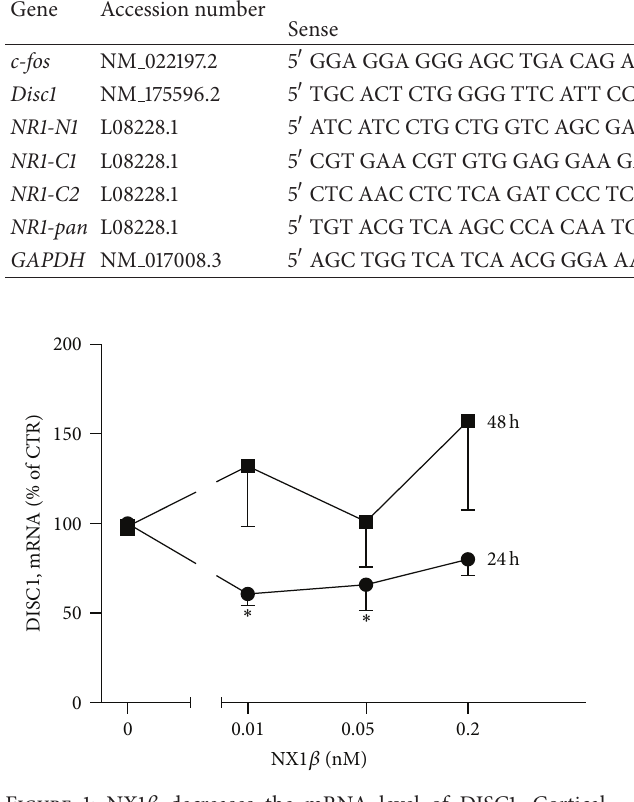
Figure 1: NX1 𝛽 decreases the mRNA level of DISC1. Cortical neurons were grown for 8 days and subsequently treated with different concentrations of recombinant NX1 𝛽 for (a) 24 h and (b) 48 h. Total RNA was isolated, and mRNA levels were assessed using RT-PCR. The results from 𝑛 = 3 experiments are expressed as a percentage ± SEM. ∗ 𝑃 < 0.05 , compared with the untreated control set at